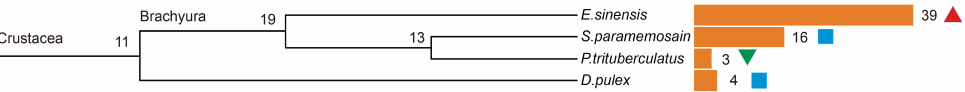
Figure 1. Distribution of DDE transposase 4 (DDE_Tnp_4) family genes gain and loss among crustaceans. The numbers on nodes represent a total number of DDE_Tnp_4 family genes for ancestral species. The red positive triangle represented that genes in this species expanded significantly. The green inverted triangle represented that genes in this species contracted significantly. The blue square represented that genes in this species did not expand or contract significantly.